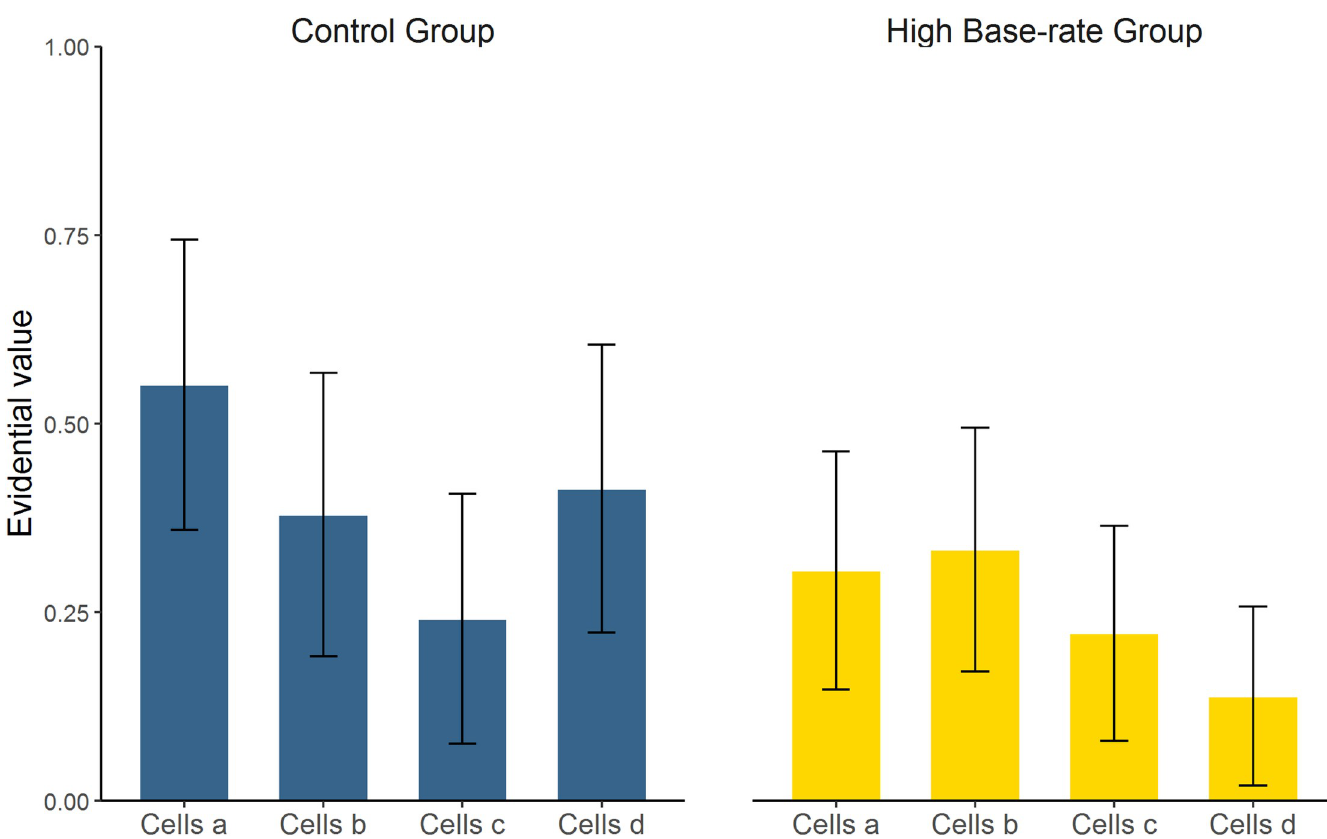
Fig 4. Mean proportion of “evidence” answers to the evidential value questions in Experiment 1, by type of trial: cells a , b , c , and d . Error bars depict 95% CIs for the mean.